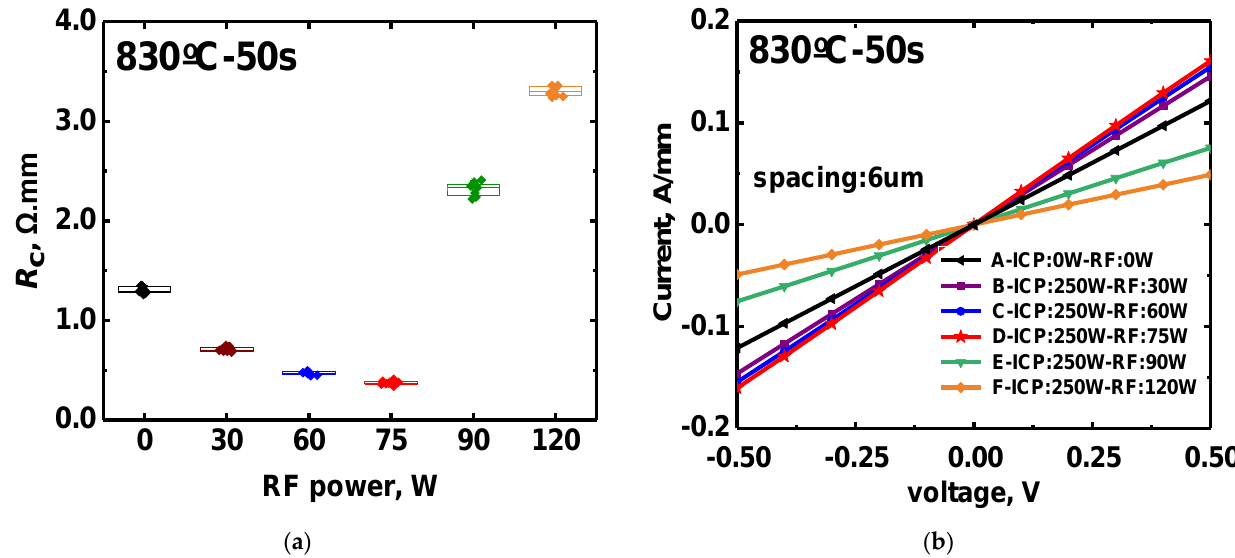
Figure 6. Impact of radio frequency (RF) power on R C . ( a ) R C with different RF power. ( b ) I–V characteristic curve of different RF power.